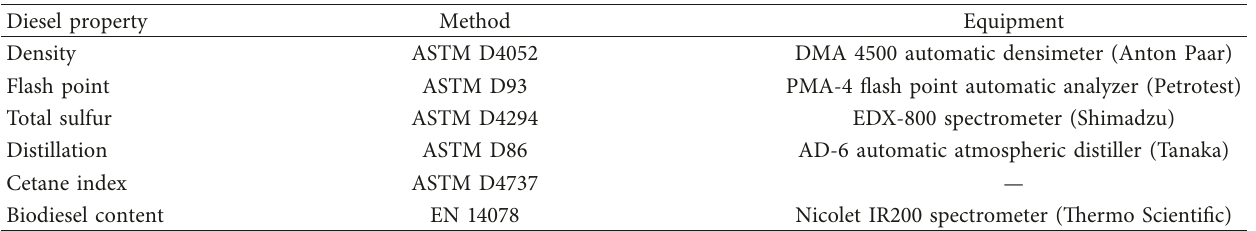
Table 1: Standard methods and equipment used to determine the quality parameters of diesel